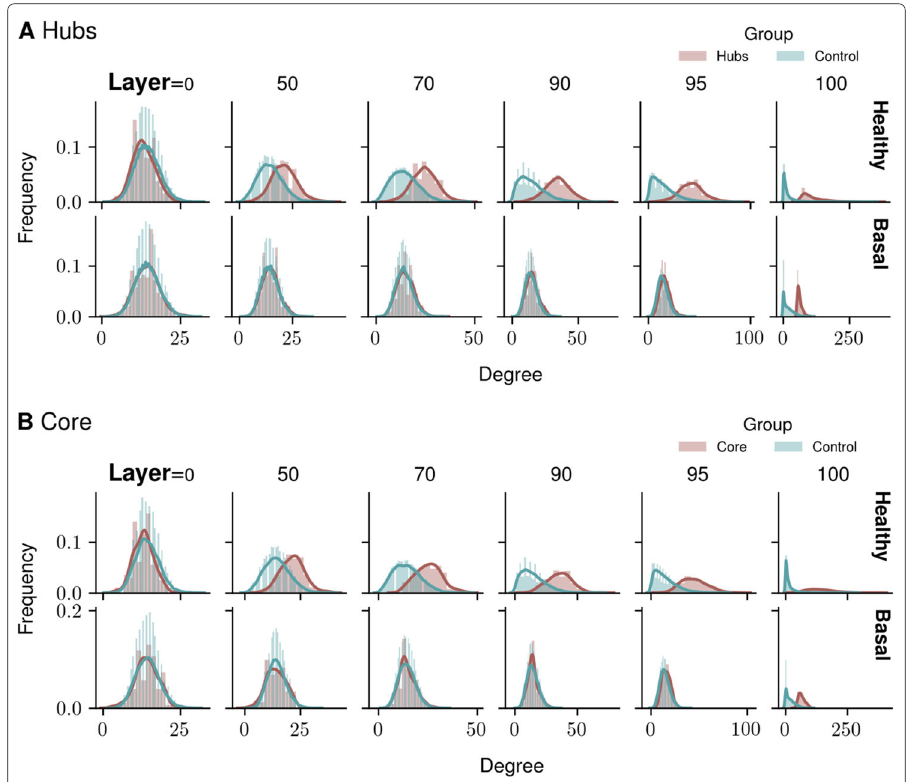
Fig. 6 The evolution of degree of highly connected nodes in the top co-expression layer. Two groups of highly connected nodes are considered: hub nodes and the nodes in the main core of the top co-expression layer. a The hub nodes are defined as the nodes with a degree greater than two standard deviations from the mean ( d hub ≥ μ + 2 σ ). b The core of a network is a well-defined set of highly inter-connected nodes (see for example (Seidman 1983)). For each GCN and each layer, degree distribution of each group is compared to that of a control set of nodes using a Z -test. This control group is obtained by picking at random 100 set of nodes of the same size. The cardinality of the hub sets is 533 and 534 for the healthy and Basal GCNs, respectively; and 141 and 133 in the case of the